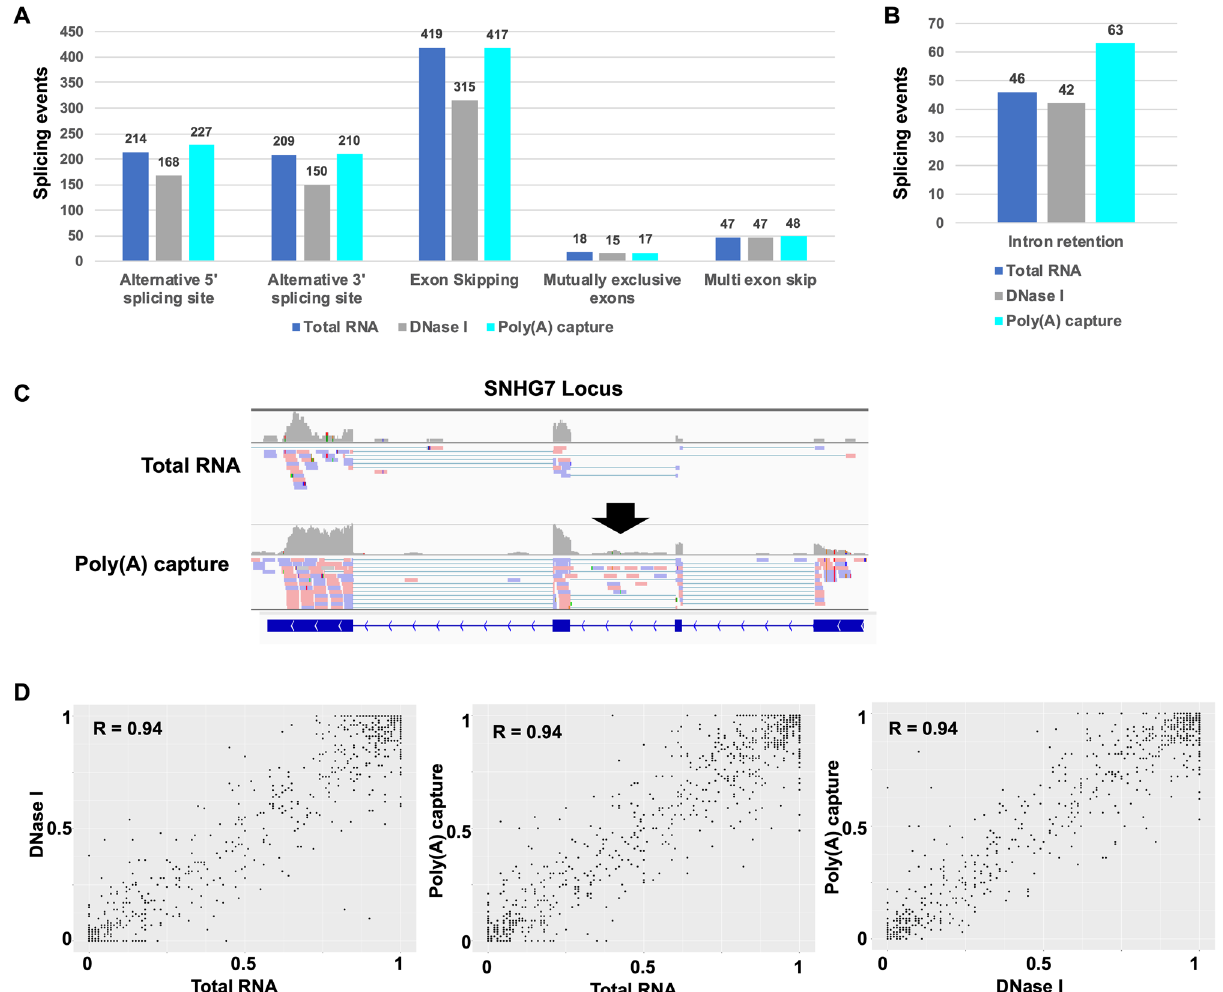
Figure 5. Comparison between Total RNA, DNase I-treated, and Poly( A ) capture sequencings for alternative splicing analysis using SplAdder. The splicing event number per event patterns (alternative 5’ splicing site, alternative 3’ splicing site, Exon skipping, mutually exclusive exons, and multi-exon skip). ( B ) The number of intron retention. ( C ) The mapped reads at SNHG7 locus in the integrative genomic viewer (IGV). Black arrow indicated intron retention). ( D ) Scatter plot of the percent splicing index (PSI). The PSI of the splicing events were calculated by SplAdder. The p -value were calculated by